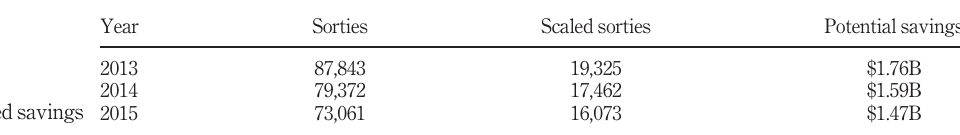
Table III. Extrapolated